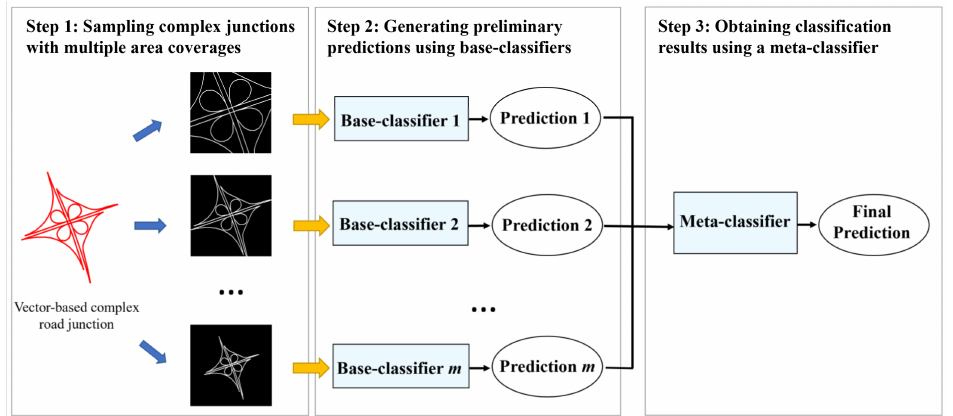
Figure 1. Overall framework of the proposed stacking ensemble (SE) learning method for classifying the patterns of complex road